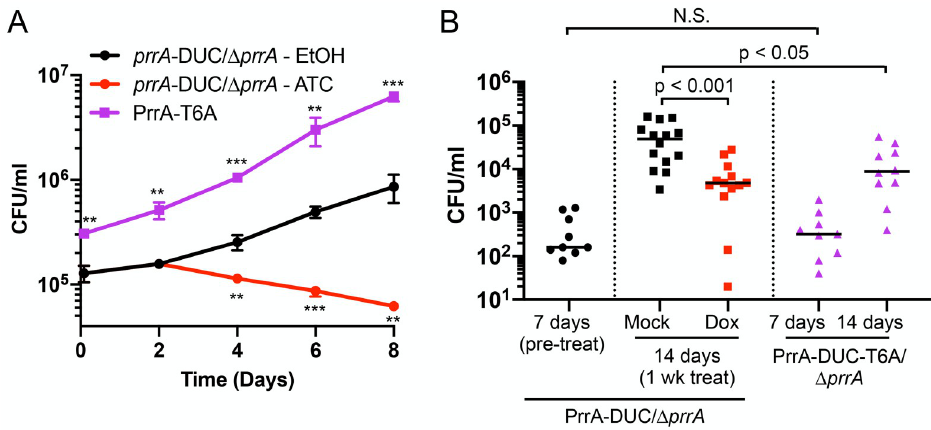
Fig 8. PrrA is critical for successful host colonization by Mtb. (A) prrA perturbation affects Mtb colonization of primary macrophages. Murine bone marrow-derived macrophages were infected with PrrA-DUC/ Δ prrA or PrrA-T6A-DUC/ Δ prrA (“PrrA-T6A”) Mtb. 0.1% EtOH or 200 ng/ml ATC was added 2 days post-infection for the PrrA-DUC/ Δ prrA strain, with media replenished every 2 days for all strains. Data are shown as means ± SD from 3 wells. p-values were obtained with an unpaired t-test, comparing ATC-treated PrrA-DUC/ Δ prrA or PrrA-T6A-DUC/ Δ prrA to EtOH-treated PrrA-DUC/ Δ prrA . �� p < 0.01, ��� p < 0.001. (B) prrA perturbation inhibits Mtb colonization of mice. C3HeB/FeJ mice were infected with PrrA-DUC/ Δ prrA or PrrA-T6A-DUC/ Δ prrA Mtb. PrrA-DUC/ Δ prrA Mtb infected mice were provided drinking water supplemented with 5% sucrose (“mock”) or 5% sucrose + 1 mg/ml doxycycline (“dox”) one-week post-infection for an additional week (two weeks total). Mice were sacrificed and lungs homogenized and plated for bacterial load at indicated time points. Each data point represents an individual mouse. Horizontal lines depict the median. P-values were obtained with a Mann-Whitney statistical test. N.S. not